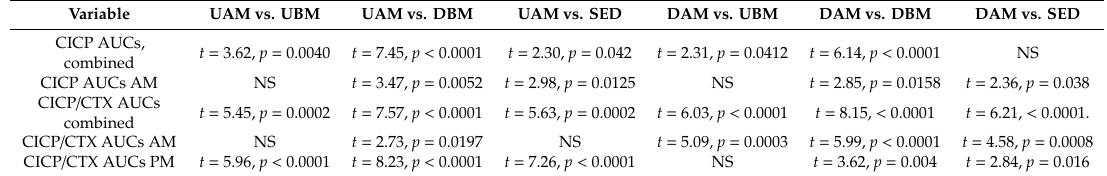
Table 3. Statistical di ff erences for CICP and CICP / CTX AUC group